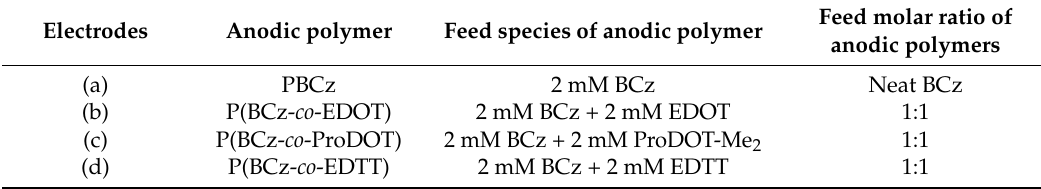
Table 1. Feed species of anodic polymer electrodes (a), (b), (c), and (d).